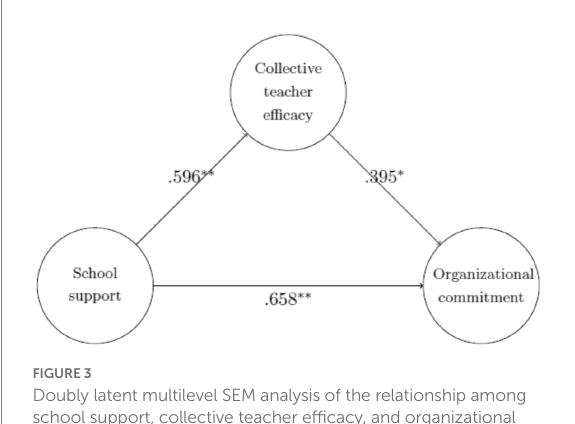
FIGURE 3 Doubly latent multilevel SEM analysis of the relationship among school support, collective teacher efficacy, and organizational commitment (school-level SEM model). * p < 0.05; ** p <